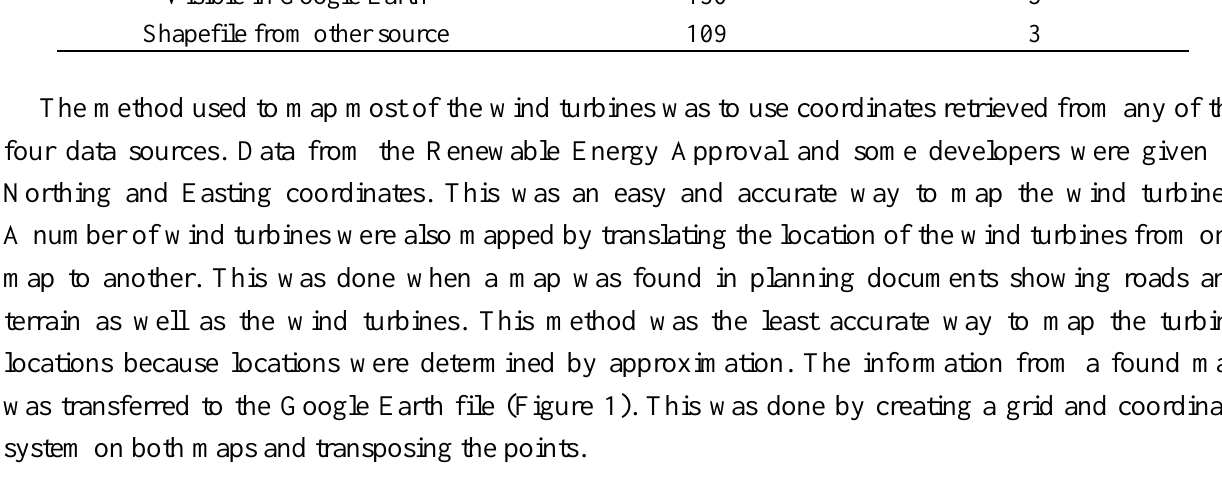
Figure 1. Map from the notice of completion for Front Line Wind